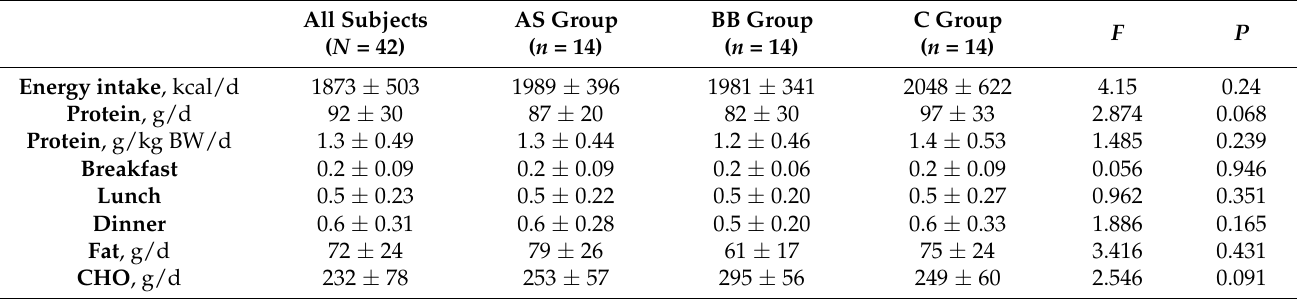
Table 2. Total dietary intake and dietary intake at each meal at baseline.